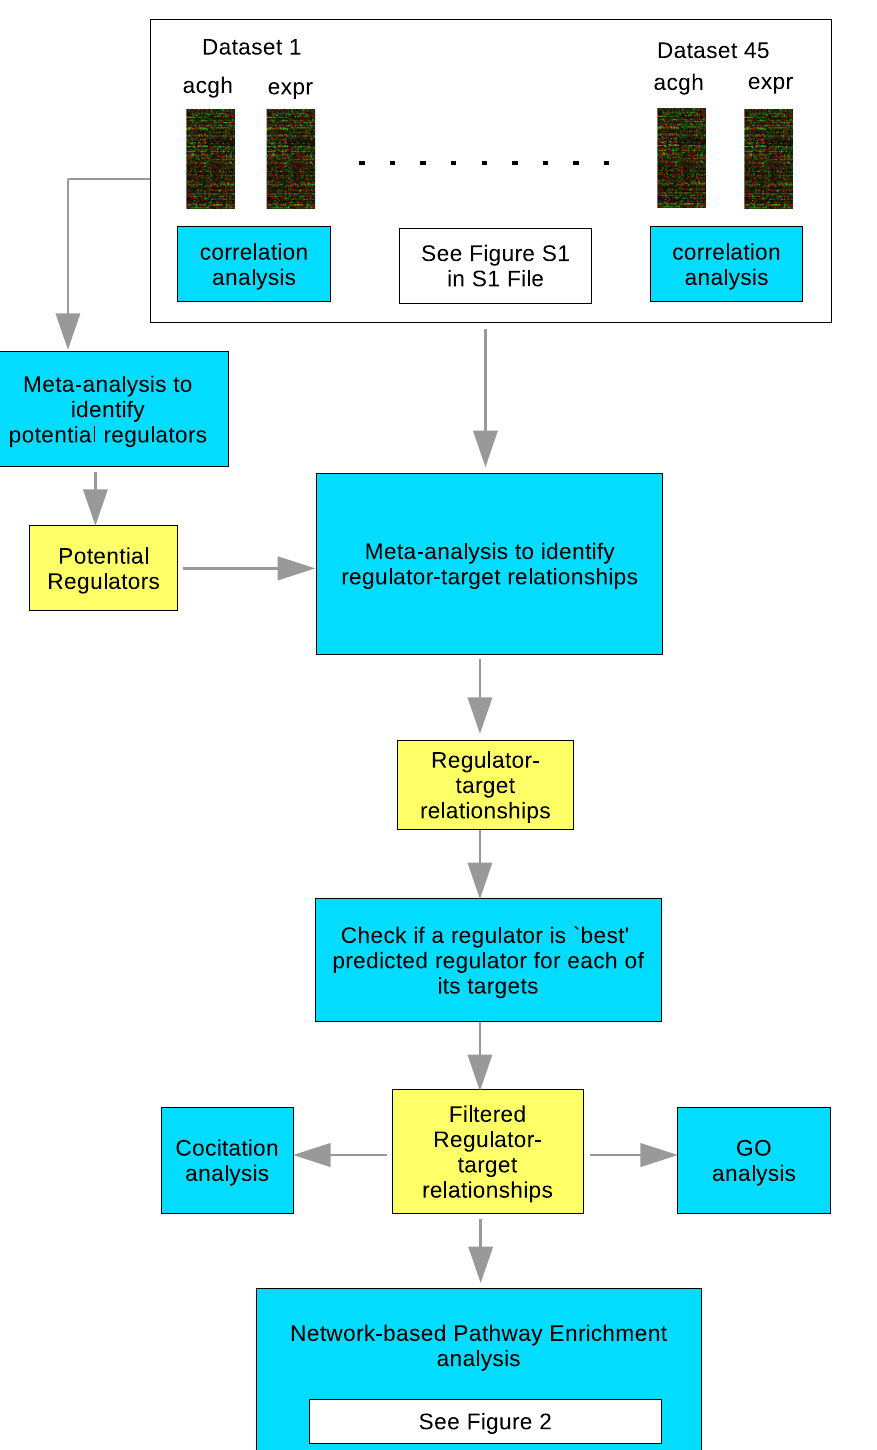
Fig 1. Schematic diagram showing the steps involved in the analysis.